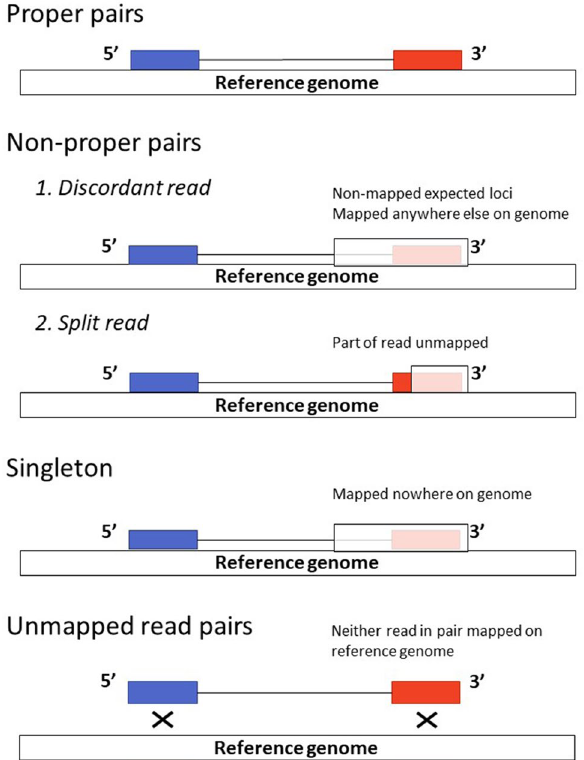
Figure 1. Conceptual diagram of sequencing reads mapping to the reference pig genome. White boxes denote an image of the pig reference genome sequence. Blue and red boxes connected with lines denote the 5 ′ and 3 ′ ends of a paired-end sequencing read. Most paired-end reads were identified as proper mapping while a small percentage of them were non-proper mapping. One end of the paired-end sequence mapped correctly while the other end was only partially identified at the expected locus on the reference genome. The unidentified sequence could be mapped anywhere else on the reference genome. For singletons, one end of the paired-end sequence mapped correctly while the other end did not map on the reference genome. For unmapped read pairs, neither read mapped to the reference